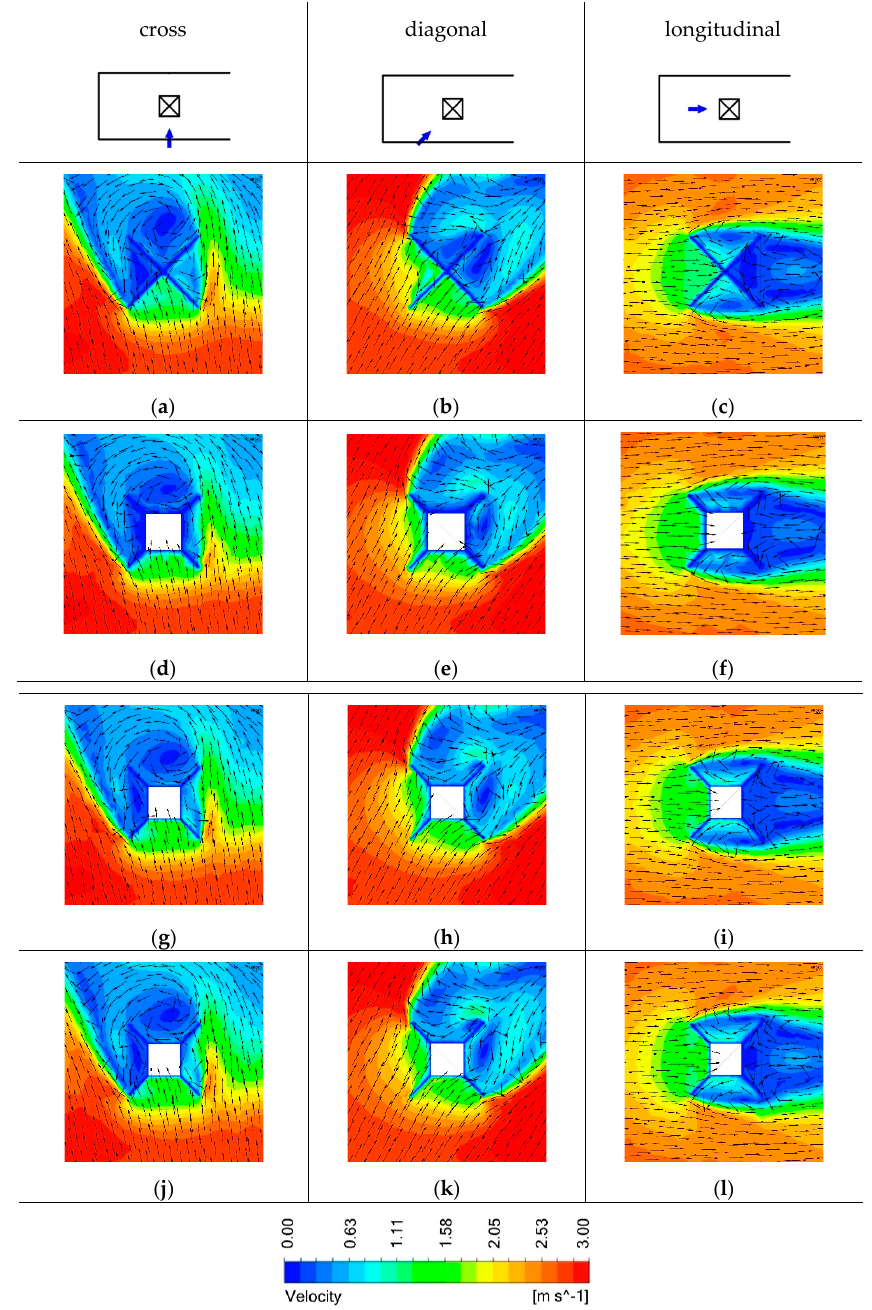
Figure 8. Representation of flow fields around the wind catcher variations by velocity color maps and normalized, tangentially projected vector fields on the 1.40 m high horizontal section: ( a–c ) ‘empty’; ( d–f ) ‘circle’, ( g–i ) ‘parabola’, ( j–l ) ‘hyperbola’—in the following order: cross ( a ), diagonal ( b ) and longitudinal ( c ) wind direction.